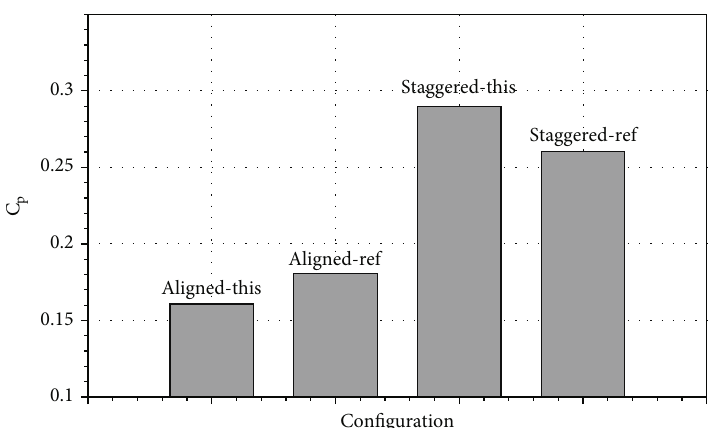
Figure 9: Average C P comparisons of aligned and staggered wind